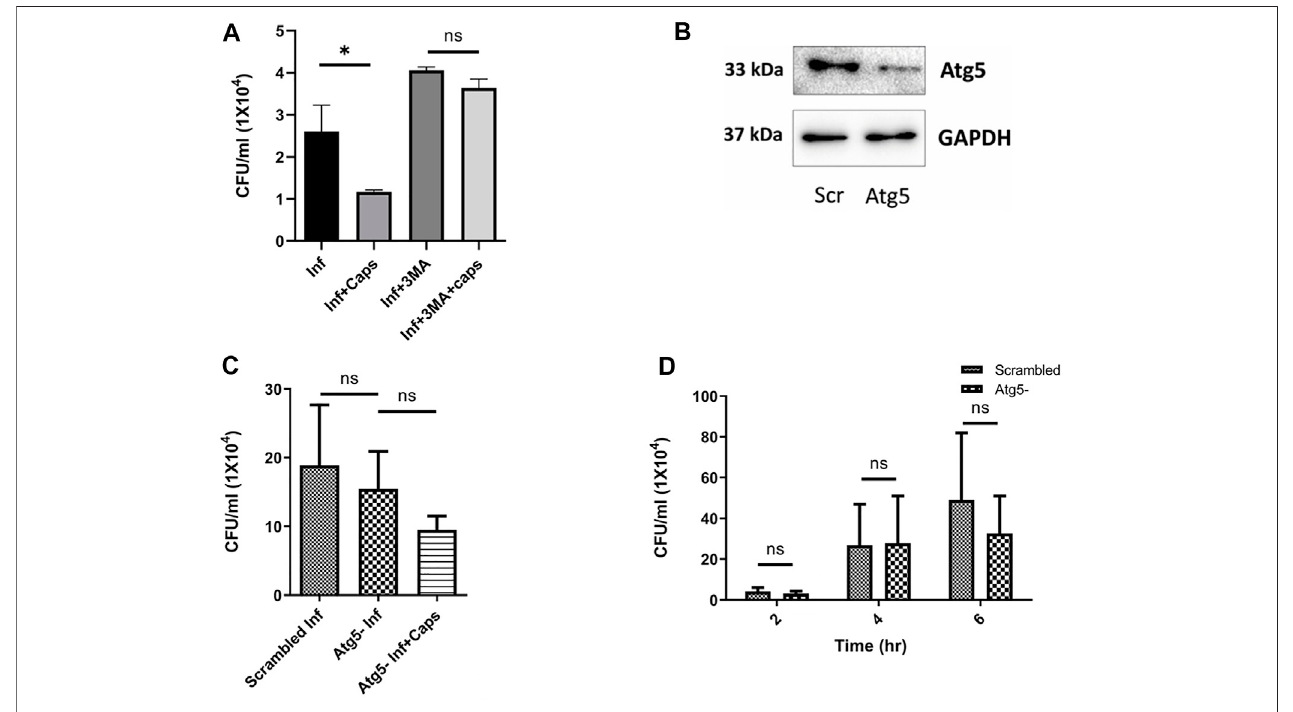
FIGURE5| Autophagyinhibitioninducedbacterialgrowth. (A) Intestinalcellsweretreatedwith3MA(5mM),Caps(16µM)for2 h,furtherinfectedwith S. fl exneri for 2 h followed by gentamicin treatment. Infection assay was performed. Graph represents intracellular bacterial count. One-way ANOVA was performed. (B) Cells were transfectedwithscrambledandAtg5 siRNA. WesternblotshowstheAtg5expression inscrambled andknockdowncells. GAPDHwaskeptasahousekeepingcontrol. (C) Infection assay was performed in scrambled and Atg5 knockdown cells treated with Caps for 2 h followed by infection. CFU/ml was graphically represented. One-wayANOVAwasperformed. (D) InfectionassaywasperformedinscrambledandAtg5knockdowncellsfordifferenttimepoints(2,4,6 h).Brie fl y,aftertransfection withscrambledandAtg5siRNA,cellswereinfectedfordifferenttimepoints.CellswerelysedandplatedforCFUcount.GraphswererepresentedusingGraphPadPrism 5 as mean ± SEM (n = 3); signi fi cance was calculated by two-way ANOVA; * p < 0.05, ** p < 0.01, *** p < 0.001.